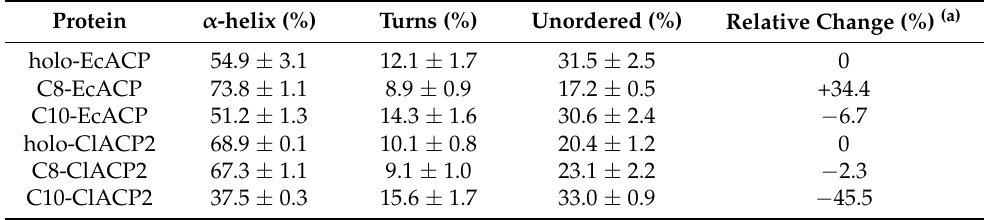
Table 2. The secondary structure contents of acyl-ACPs calculated by Dichroweb program. Protein α -helix (%) Turns (%) Unordered (%) Relative Change (%)